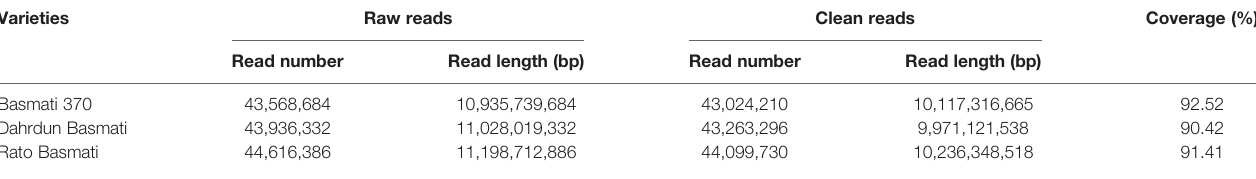
TABLE 2 | Data generated from whole-genome resequencing of three Basmati varieties.